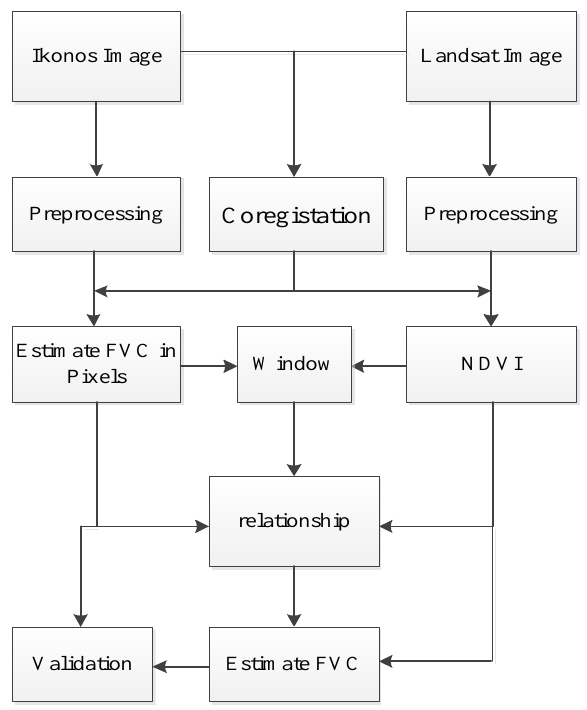
Figure 3. Flowchart for vegetation fraction